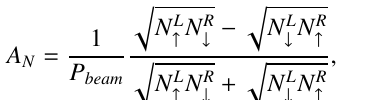
√ s = 62 GeV. Their results are found to be consistent Also shown in Fig. 6 are A N ( π 0 ) measurements made by the E704 collaboration at FermiLab. E704 used a 200 GeV polarized proton beam incident on a fixed target [22]. The √ s dependence for A N will be discussed further below. Neutral pion results have been reported by the STAR collaboration at rapidities intermediate between the central and forward regions (1 < η < 2) [24]. As for the central and forward rapidity regions, cross sections at mid-central rapidity are consistent with NLO pQCD. A N for neutral central rapidity